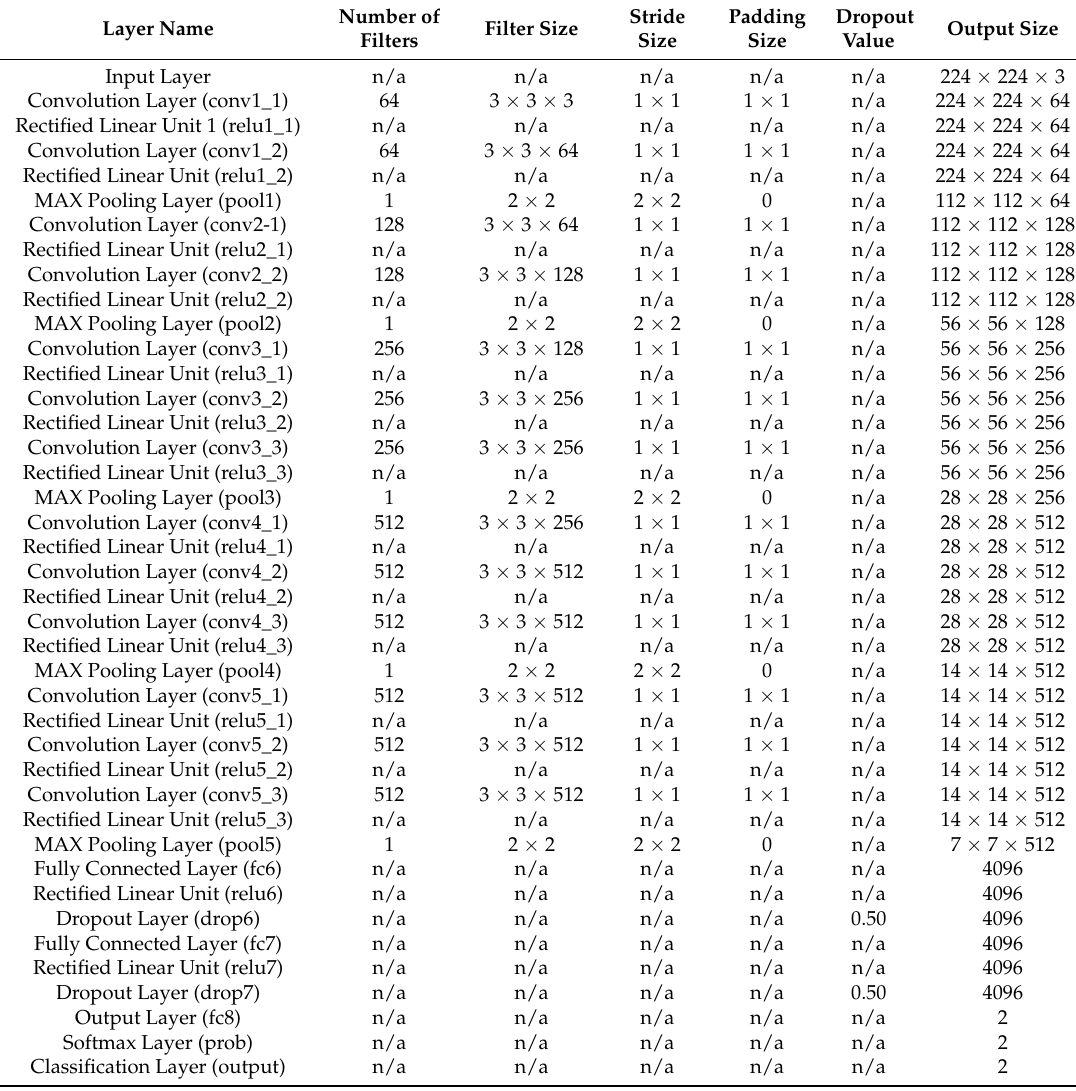
Table 4. Description of CNN structure based on VGG-16 network for PAD